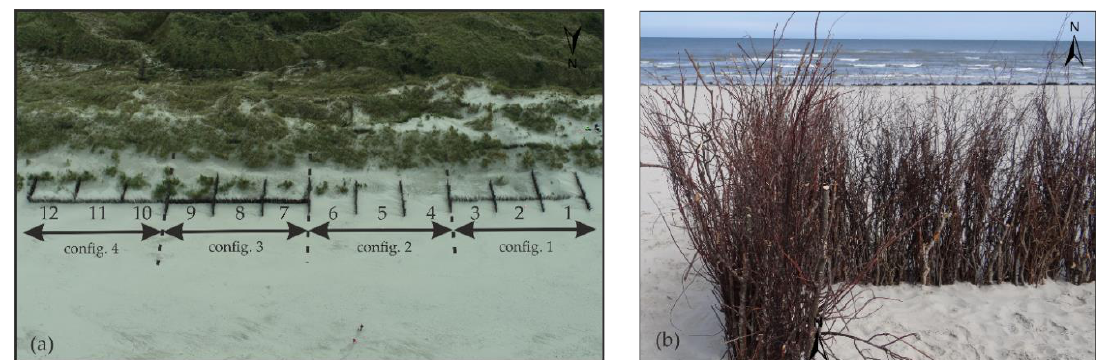
Figure 2. ( a ) Aerial drone photograph of the sand trapping fence with different configurations and ( b ) a close-up of the sand trapping fence consisting of brushwood on the study site of Langeoog (20 May 2020).